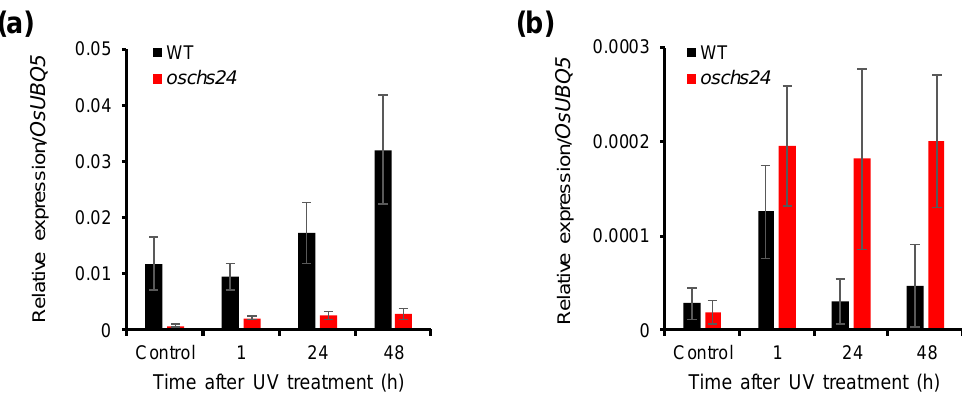
Figure 6. Analysis of the OsCHS24 ( a ) and OsCHS8 ( b ) expression in oschs24 in response to UV irradiation. Transcript levels of OsCHS24 and OsCHS8 in the wild-type an oschs24 mutants were analyzed by qRT-PCR. An ubiquitin 5 gene ( OsUBQ5 ) was used as an internal control. Expression levels of each OsCHS gene are presented as relative expression compared to the OsUBQ5 mRNA level. qRT-PCR analysis was performed on triplicate biological samples. The results represent mean ± standard